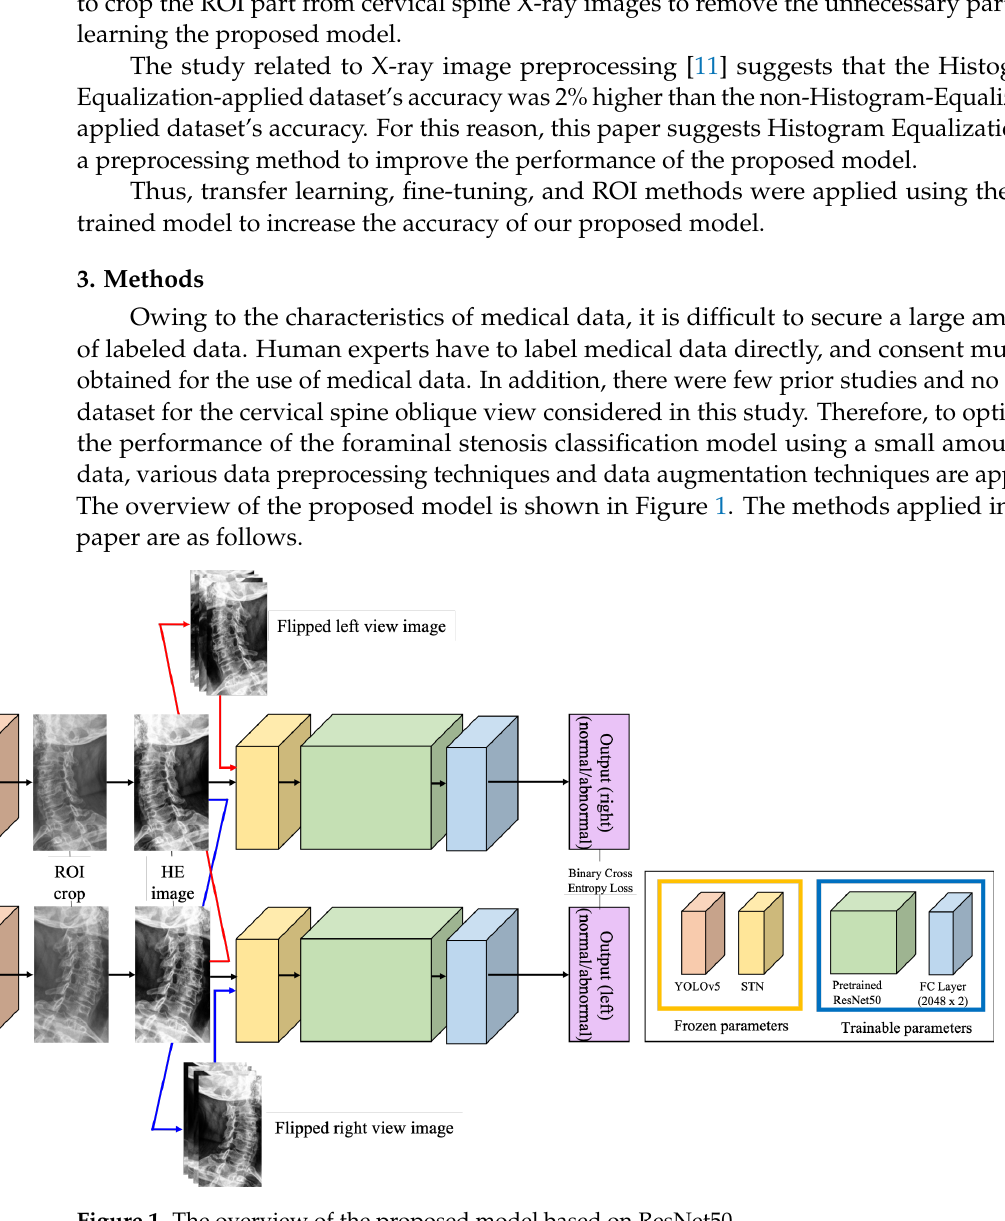
Figure 1. The overview of the proposed model based on